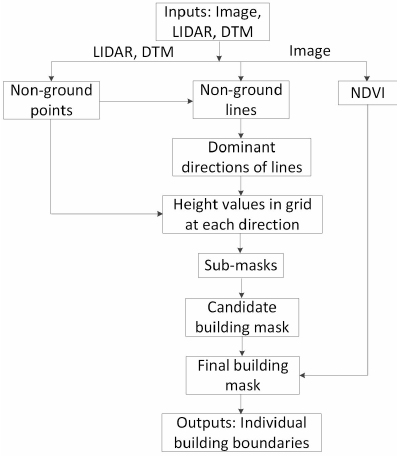
Figure 2. Flow diagram for new building detection